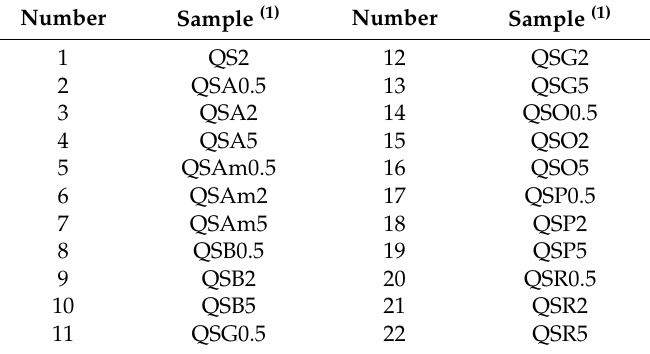
Table 6. Experimental design of chitosan-starch films with natural antioxidants. Number Sample (1)